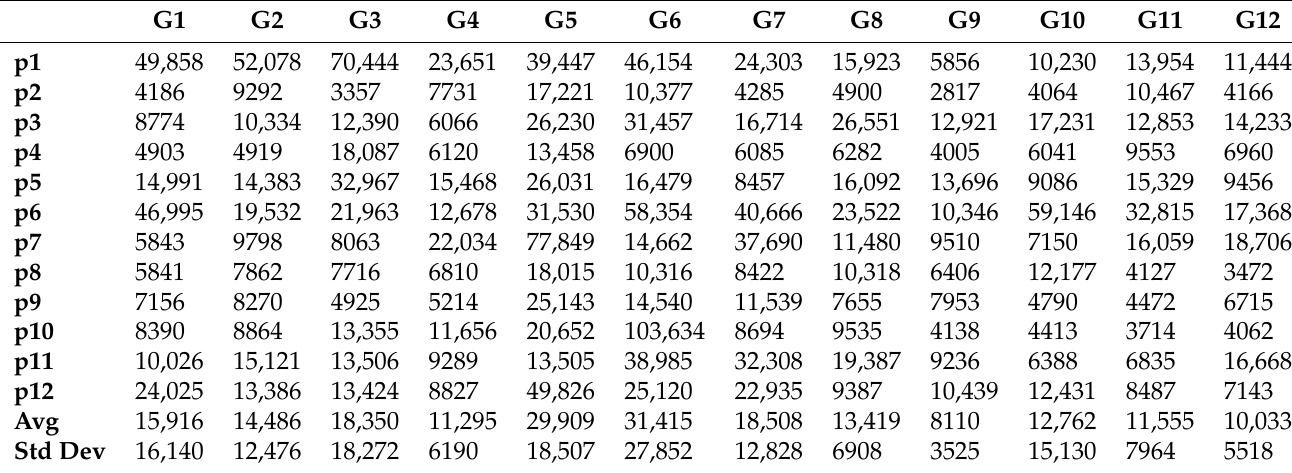
Table 3. Average time per movement, in milliseconds, for every player in each